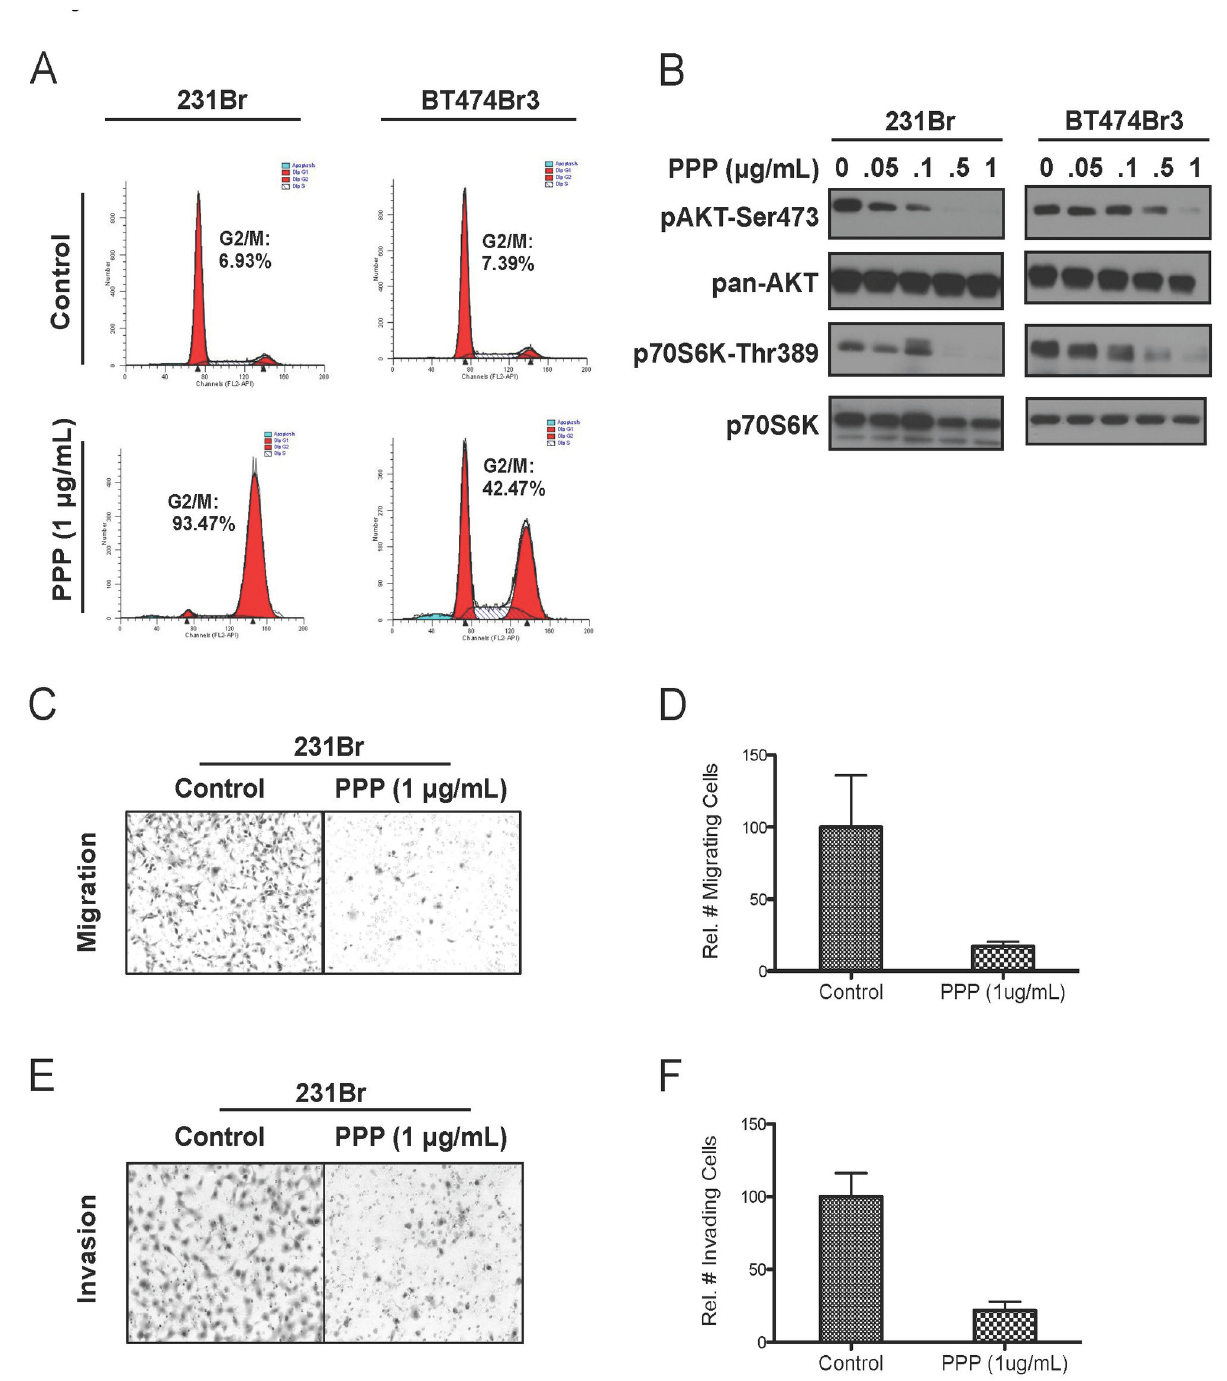
Figure 5. Picropodophyllin induces G2/M cell cycle arrest and inhibits downstream signaling and function of IGF-IR. A, Cell cycle analysis by propidium iodide staining of brain-seeking cells (231Br and BT474 Br3) treated with 1 µg/mL PPP for 48 hr. B, Immunoblot of phospho-proteins activation downstream of IGF-IR in brain-seeking cells treated with escalating concentrations of PPP for 24h. C, Transwell migration assay of 231Br cells treated with 1 µg/mL PPP for 24 hr. D, Quantitative analysis of relative number of migrating cells from (C). E, Matrigel invasion assay of 231Br cells treated with 1 µg/mL PPP for 24 hr. F, Quantitative analysis of relative number of migrating cells from (E). All migration and invasion assays used complete medium as a chemoattractant. Bars represent mean ± SEM. doi: 10.1371/journal.pone.0073406.g005 PLOS ONE |